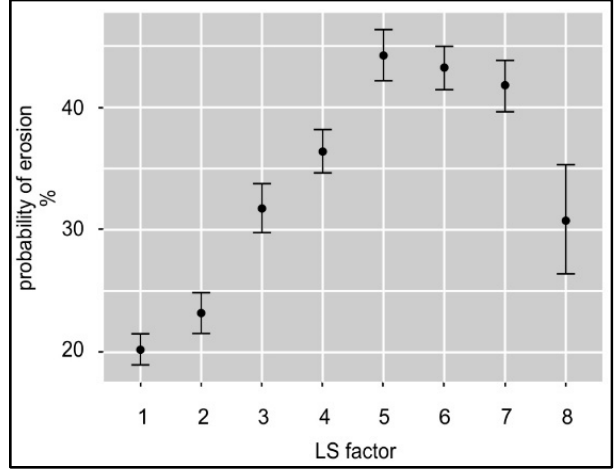
Figure 8. Category of LS factor: 1 (0–0.1), 2 (0.1–0.5), 3 (0.5–1), 4 (1–2), 5 (2–3), 6 (3–5), 7 (5–10), 8 (>10).